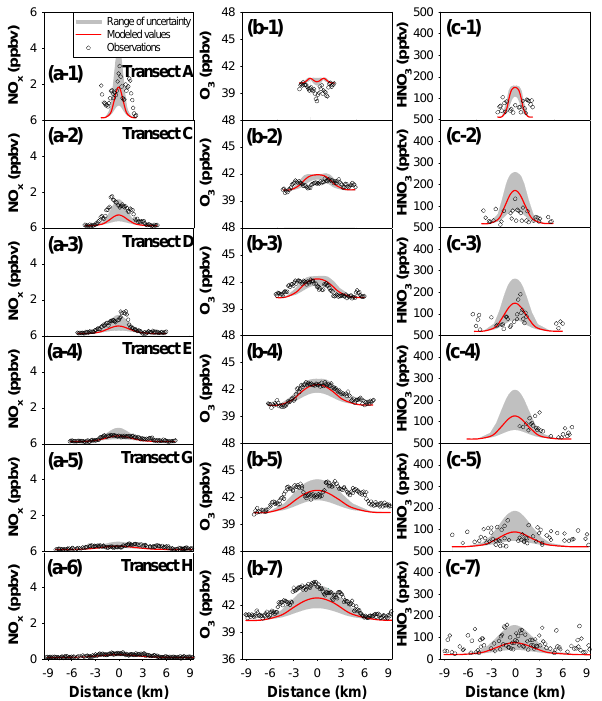
Fig. 2. Model validations at six transects for NO x , O 3 and HNO 3 . In the model simulations, the NO x emission rates from the ship were varied over a range of 2.6–13.3gs − 1 , together with primary NMVOC and HCHO emissions under the moderately stable MBL condition. The grey-shaded areas represent the varying ranges of mixing ratios of the three species. The red-solid lines represent the mixing ratios simulated from the most-likely emission